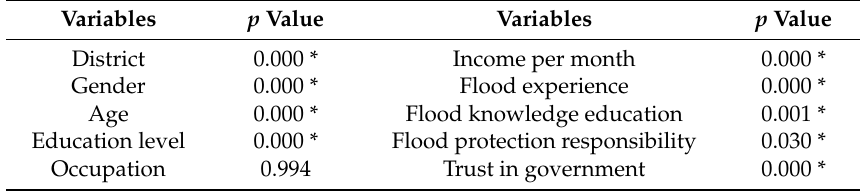
Table 5. Analysis of variance (ANOVA) results of impact factors and public flood risk perception. Variables